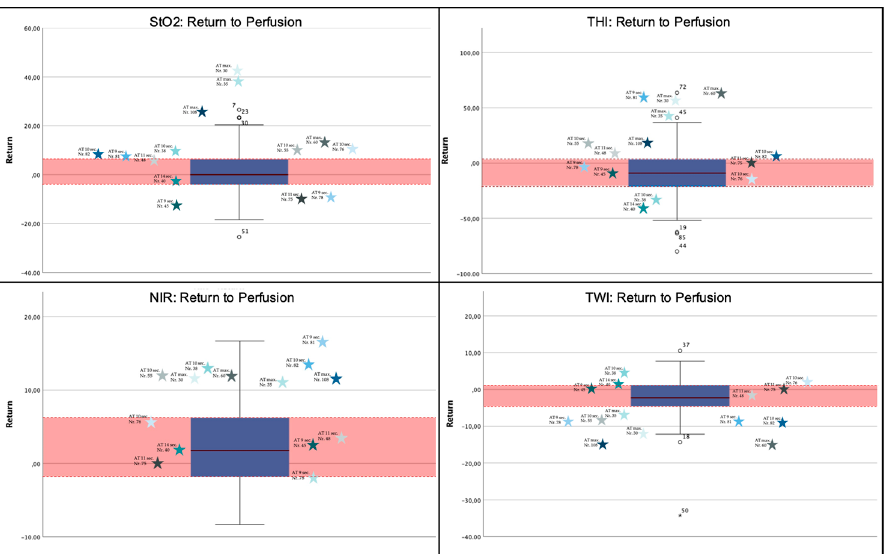
Figure 6. Boxplot diagram of the Return-to-Perfusion (RTP) measurements. The red box highlights the area between the 1st and 3rd quartile. The stars indicate the different subjects’ measurements that had a MAT >8 s. As can be observed, some values lie between the 1st and the 3rd quartile, whereas others are located within the 4 inter quartiles range (IQR). Others lie due to their extreme values beyond these areas and are therefore considered outliers. With few exceptions, the measurements defined as outliers belong to the same patients. As can be seen, RTP-values for StO 2 , THI and TWI of patients with a clear pathological MAT typically lie beyond the 4 IQR (Nr. 30, 35, 60, 108). Others, with a MAT of 9–15 s–depending on the definition–rated as pathologic or non-pathologic, typically fall within the 4 IQR. The allocation of the values on the X-axis has no meaning.